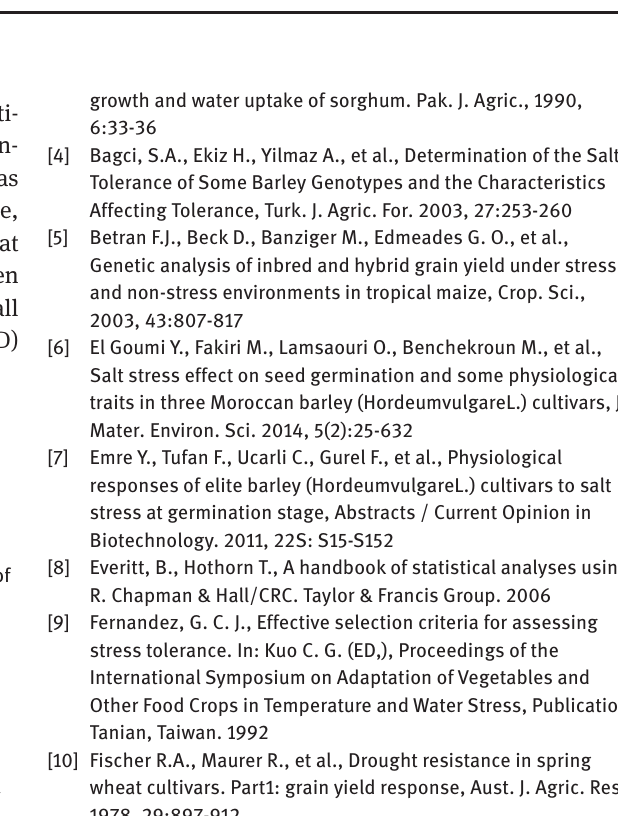
S1 (4.5 ds/m) vs. S3 (10.5